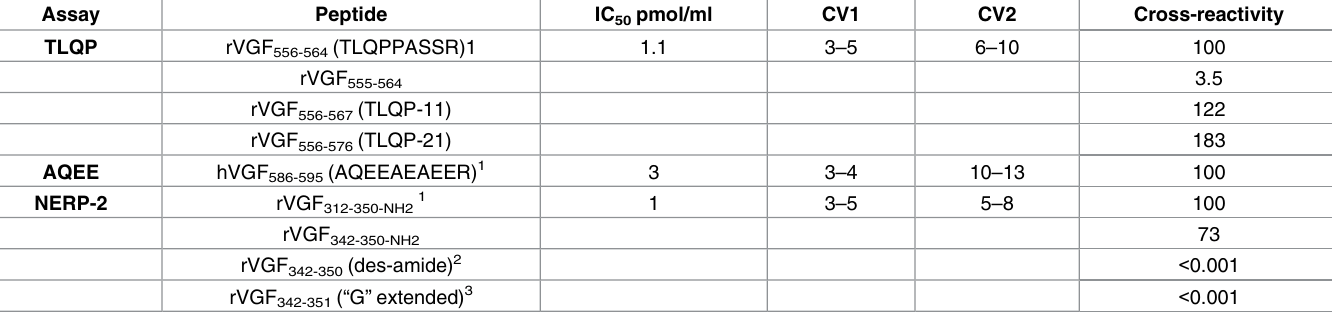
Table 1. VGF assaycharacterization. IC 50 : 50% inhibitoryconcentration; CV1 and CV2: intra- and inter-assay variation, respectively; h: human; r: rat. 1 pep- tide used for plate coating and assay standard. 2 Des-amidatedpeptideand 3 peptidewith an additionalglycineresidue at the C-terminus were used to test for cross reactivity. All of the antiseraused for the tissue VGF quantification showed100% cross-reactivity with the corresponding